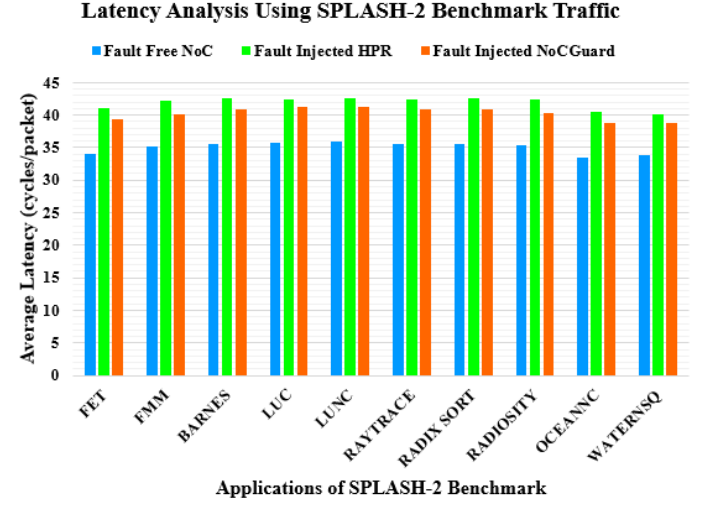
Figure 13. Average Latency for SPLASH-2 Benchmark